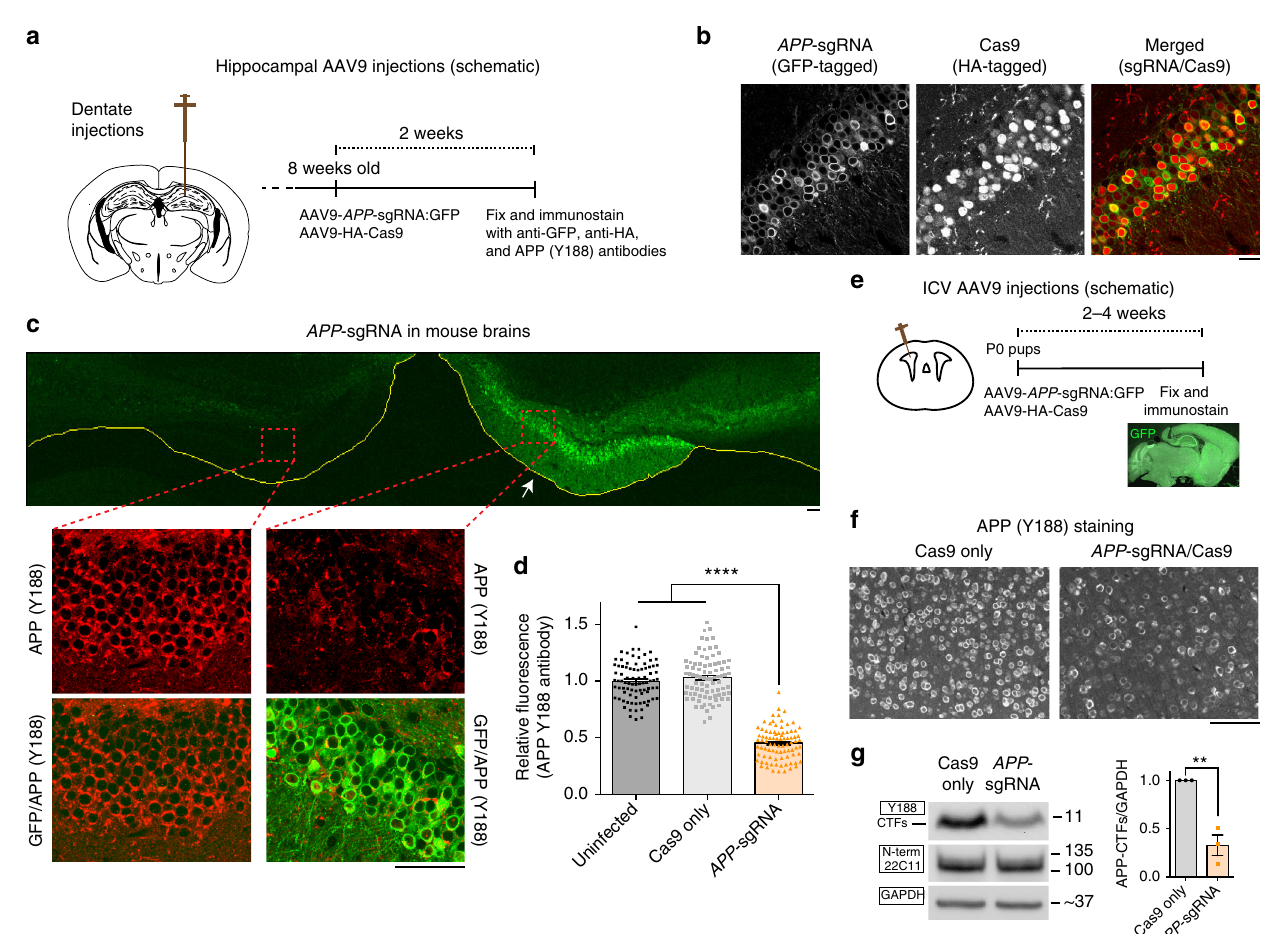
Fig. 4 Gene editing of APP C-terminus in vivo. a AAV9-sgRNA and AAV9-Cas9 were stereotactically co-injected into dentate gyrus of 8-week old mouse brains (bottom). Two weeks after viral delivery, brains were perfused, fi xed, and immunostained with anti-GFP, anti-HA and anti-APP(Y188) antibodies. b Co-expression of AAV9-sgRNA-GFP and AAV9-HA-Cas9 in the dentate gyrus. Note that majority of neurons are positive for both GFP and HA (~87% of the cells were positive for both; sampling from 3 brains). Scale bar 20 μ m. c , d Coronal section of a mouse hippocampi injected on one side (marked by arrow) with the AAV viruses as described above. Note attenuated Y188 staining of neurons on the injected side, indicating APP-editing. The image of mouse hippocampus injected with Cas9 only is not shown. Fluorescence quanti fi ed in d , mean ± SEM, data from three brains. One-way ANOVA: p < 0.0001. Tukey ’ s multiple comparisons: p = 0.4525 (Un-injected vs. Cas9 only); p < 0.0001 (Un-injected vs. APP -sgRNA); p < 0.0001 (Cas9 only vs. APP - sgRNA). Scale bars 50 μ m. e Intracerebroventrical injection of the AAV9 viruses into P0 pups. Note widespread delivery of sgRNA into brain, as evident by GFP fl uorescence. Scale bar 100 μ m. f Brain sections from above were immunostained with the Y188 antibody. Note attenuated Y188 staining in the APP - sgRNA/Cas9 transduced sample, suggesting APP-editing. g Western blots of the brains from e . Note decreased expression of CTFs in the APP -sgRNA/ Cas9 transduced brains; blots quanti fi ed on right (mean ± SEM of three independent experiments, ** p < 0.01 by two-tailed t -test). Source data are